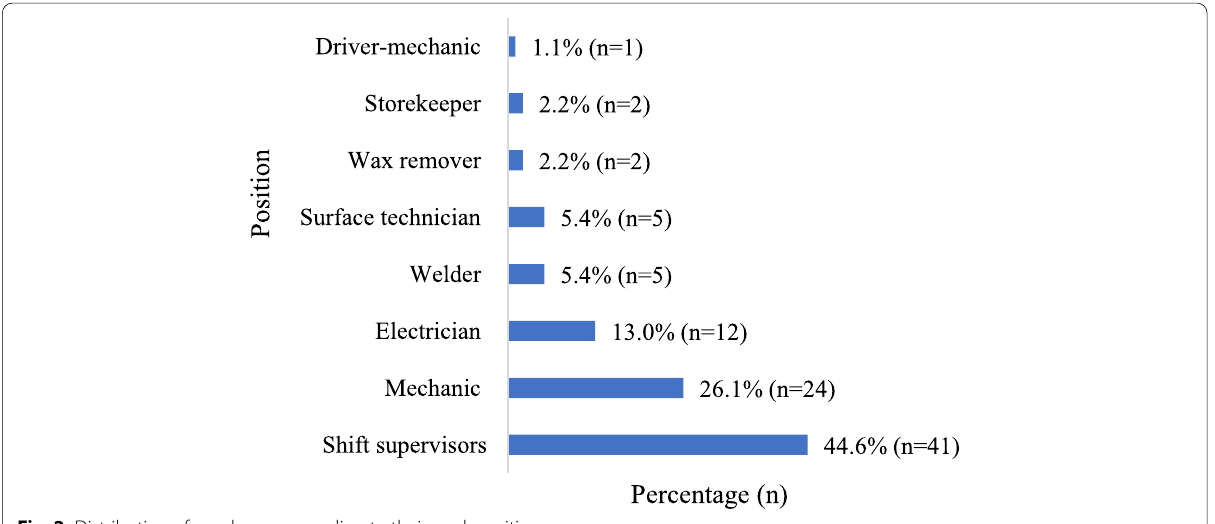
Fig. 2 Distribution of employees according to their work position